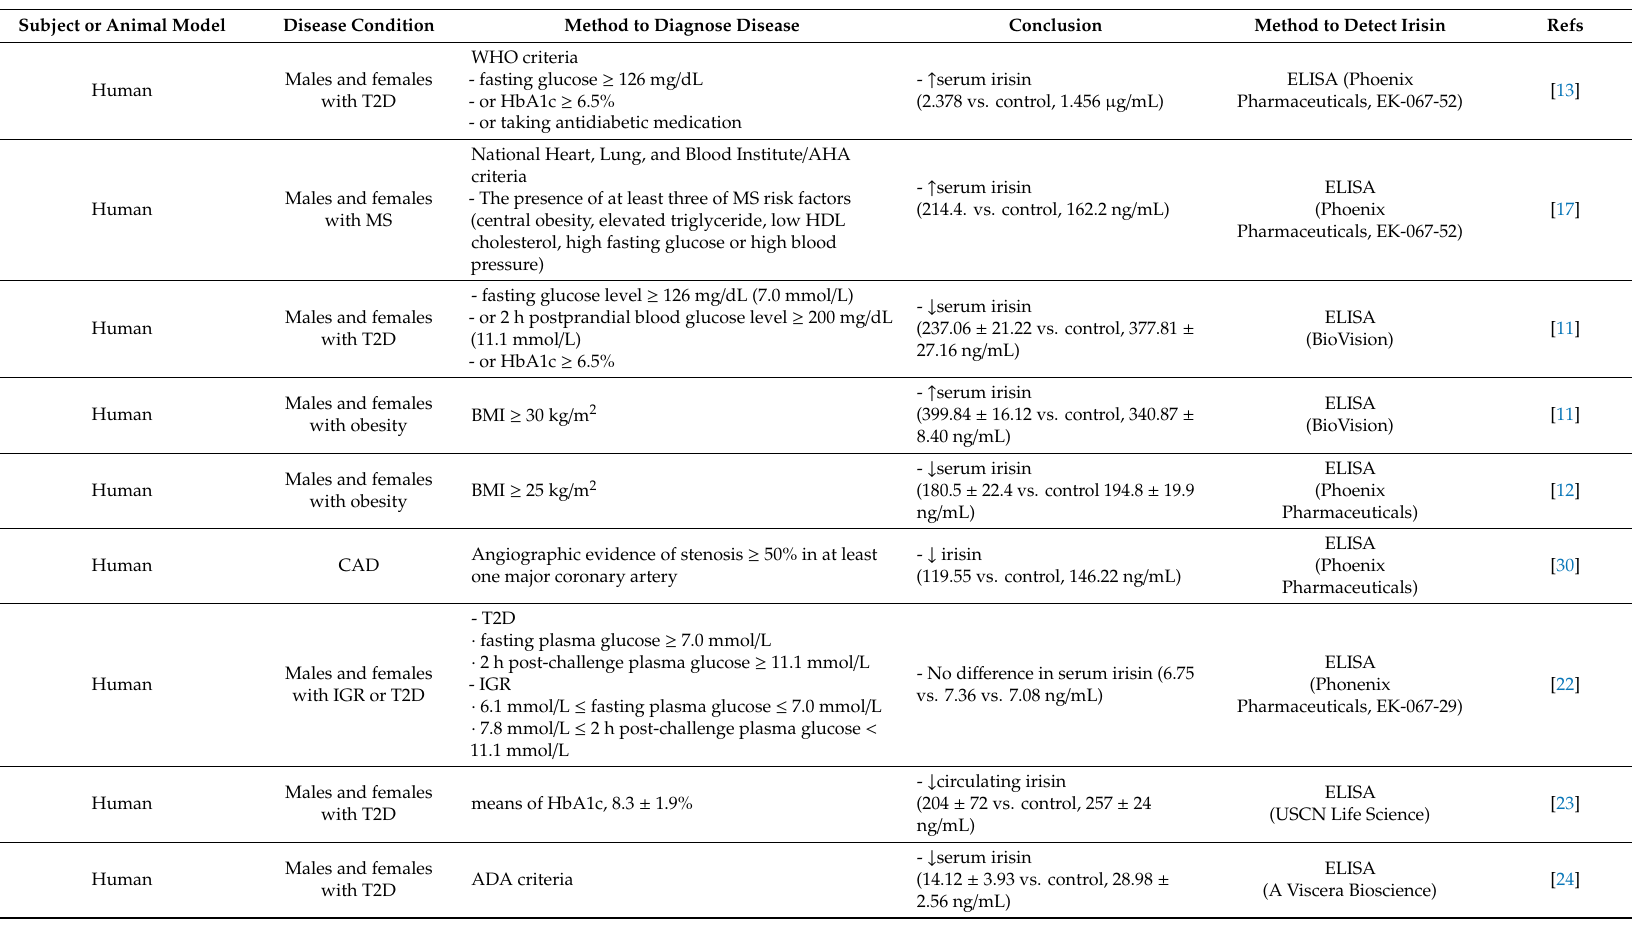
Table 1. Alteration of circulating irisin concentration according to disease condition in human and in experimental animal